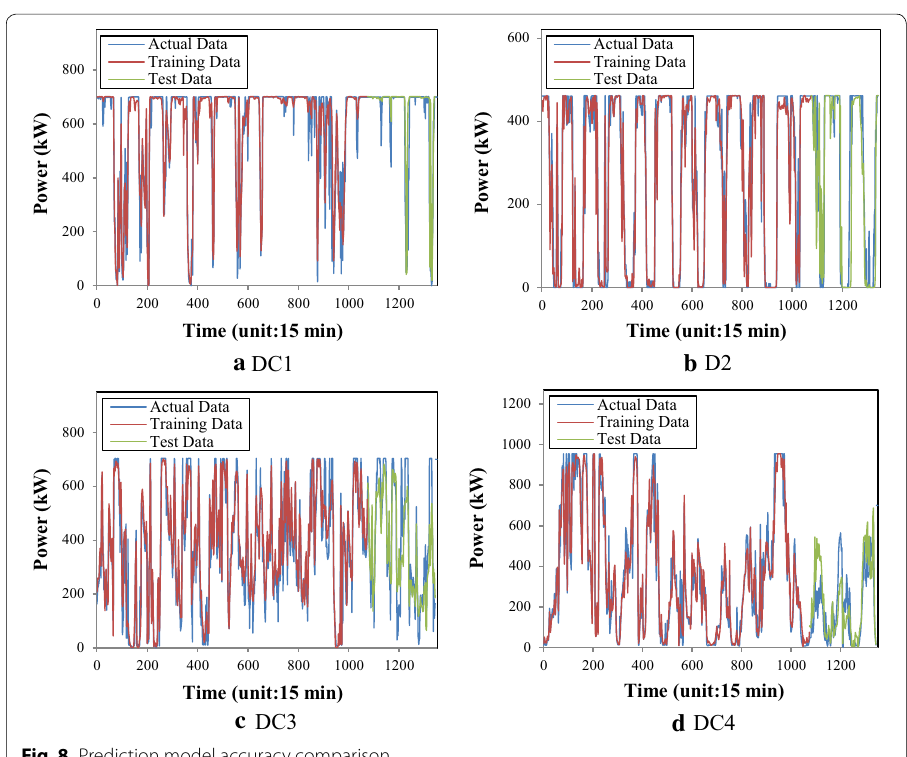
Fig. 8 Prediction model accuracy